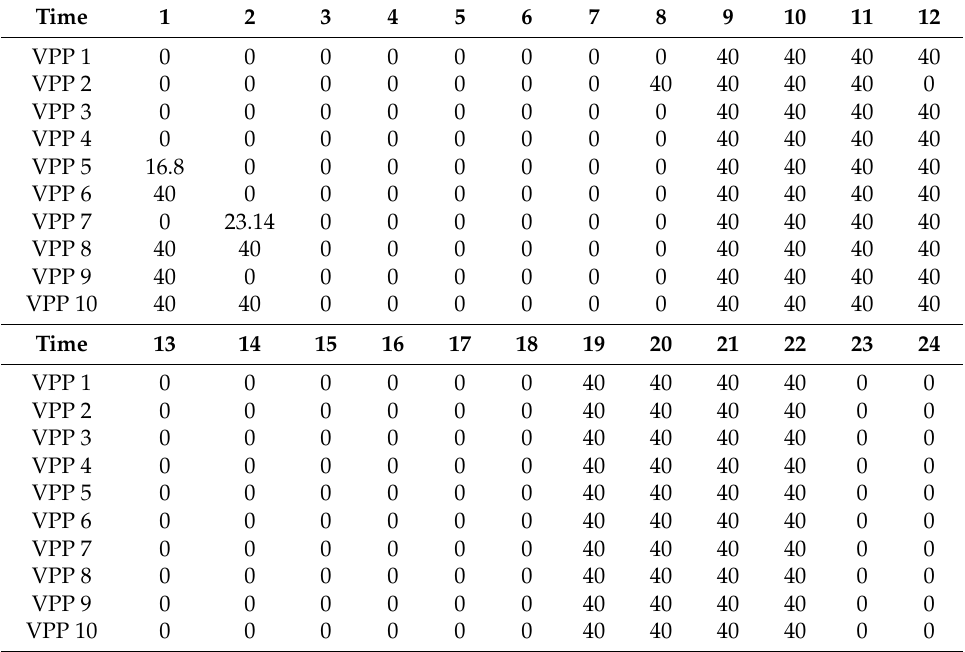
Table 4. Hourly optimal scheduling of VPPs in the modified IEEE 118-bus system.